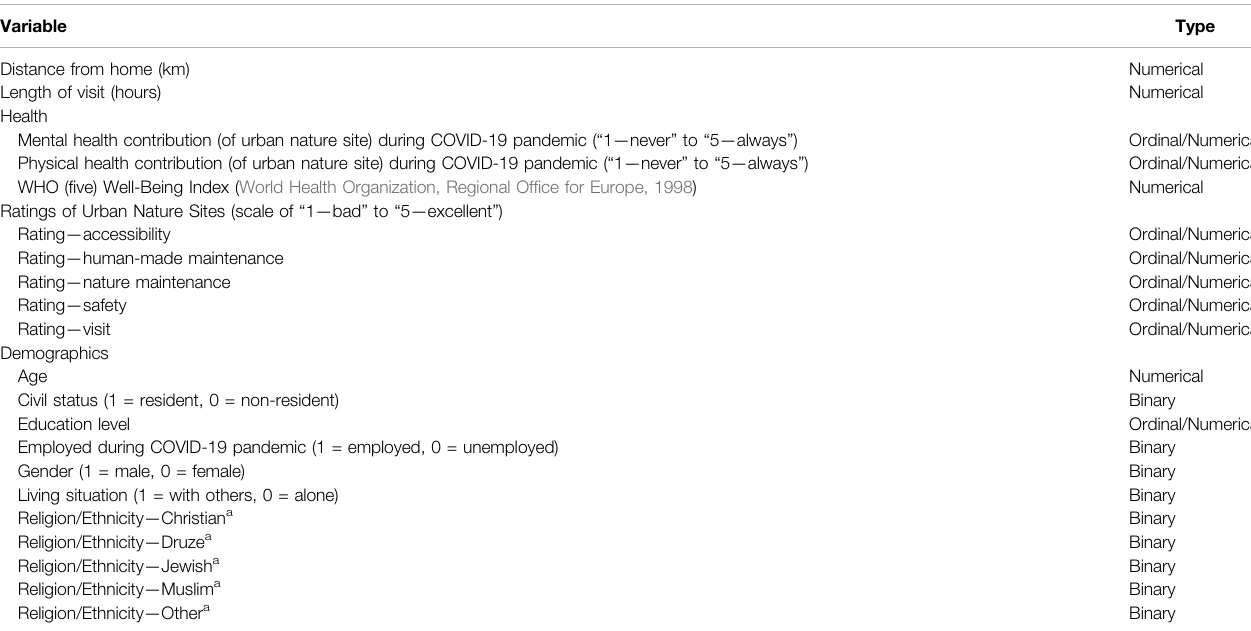
TABLE 3 | Survey variables, including those for distance from home, visit length, health, ratings, and participant